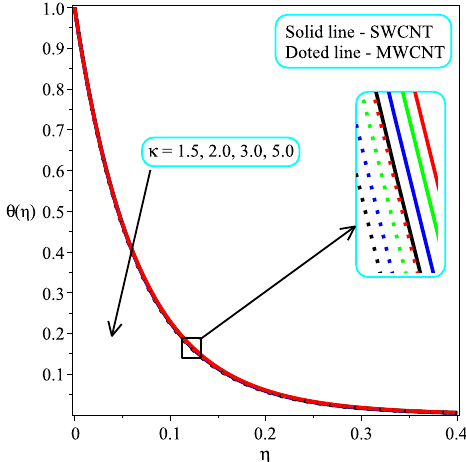
Figure 8. Repercussion of κ with φ = 0.1 M egt = 2, Ω = 1, ω = π /3, N = 1, Υ = 0.3, Pr = 100 on the temperature